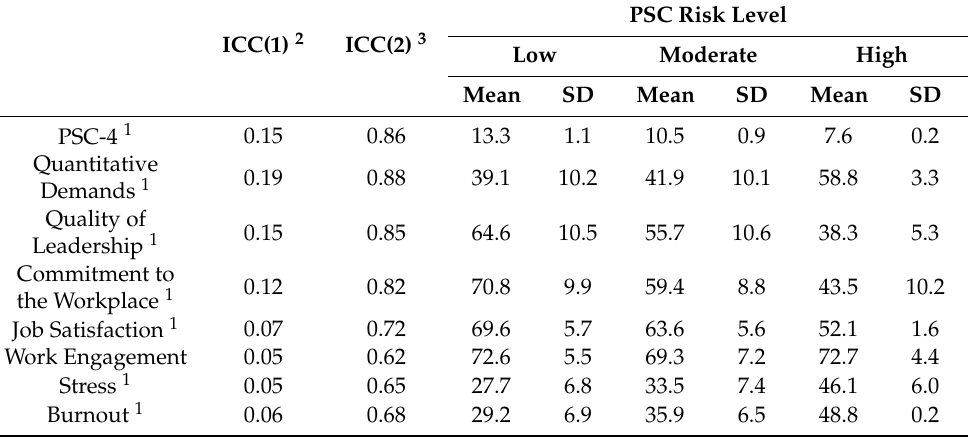
Table 5. Intraclass correlation coe ffi cients (ICC(1) and ICC(2)) for aggregation to workplace level (94 workplaces); aggregated mean and standard deviation for PSC-4 (range 1–5); and quantitative demands, quality of leadership, job satisfaction, commitment to the workplace, stress, and burnout (range 0–100) depending on PSC risk